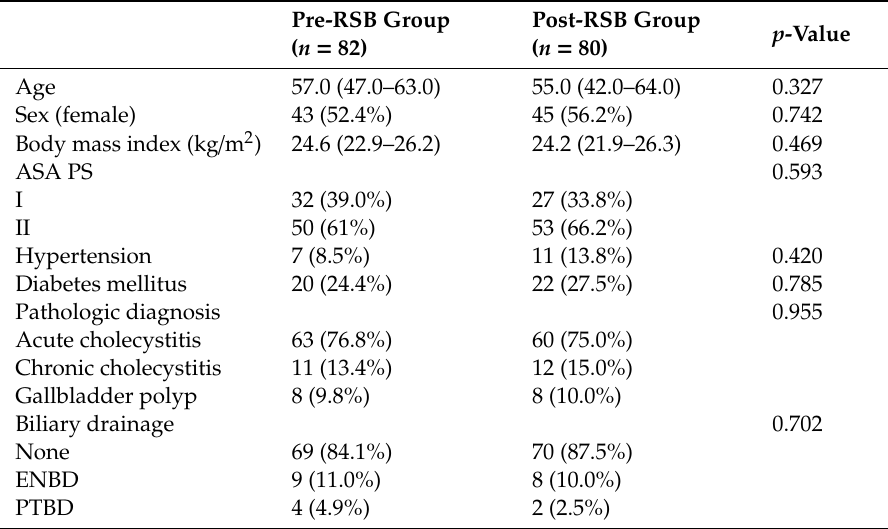
Table 1. Baseline characteristics of the study participants.